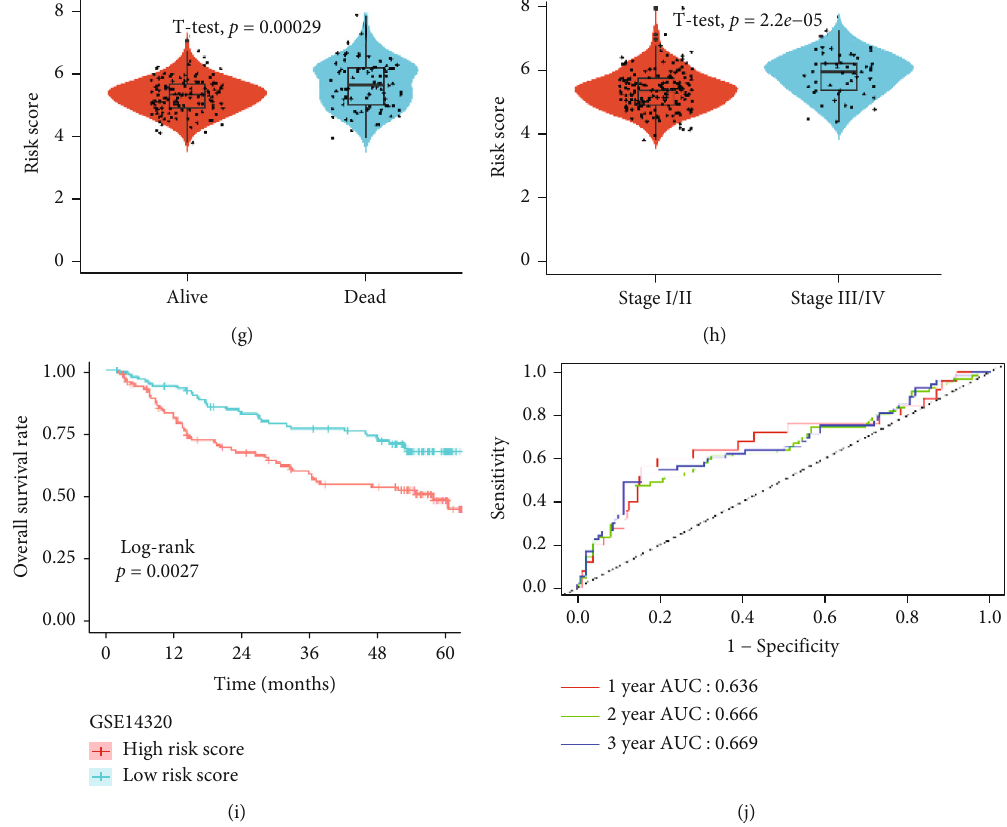
Figure 4: Validation of this feature in ICGC and GSE14520 cohorts. (a) Distribution of risk scores, OS status, and gene expression pro fi les in ICGC cohort. (b) Comparison of risk scores among patients with di ff erent survival statuses. (c) Comparison of risk scores among patients with di ff erent TNM stages. (d) Kaplan-Meier survival plot. (e) Characteristics of predicted 1-, 2-, and 3-year OS rates in ROC analysis. (f) Distribution of risk scores, OS status, and gene expression pro fi les in the GSE14520 cohort. (g) Comparison of risk scores among patients with di ff erent survival statuses. (h) Comparison of risk scores among patients with di ff erent TNM stages. (i) Kaplan-Meier survival plot. (j) Characteristics of predicted 1-, 2-, and 3-year OS rates in ROC